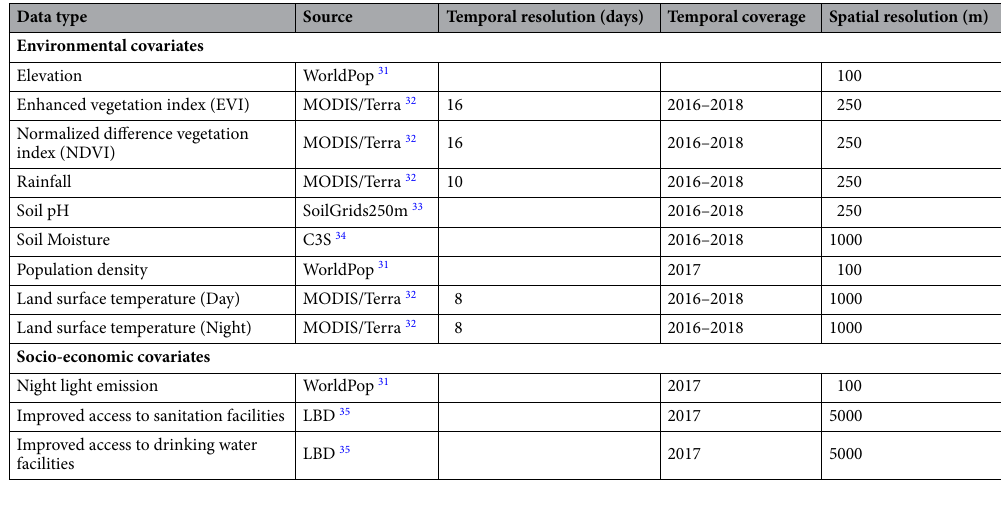
Table 1. Data sources and properties of environmental and socio-economic covariates explored to model soil transmitted helminthiasis risk in Ogun State,